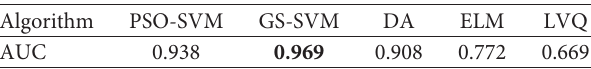
Table 3: AUC values of the five models. Algorithm